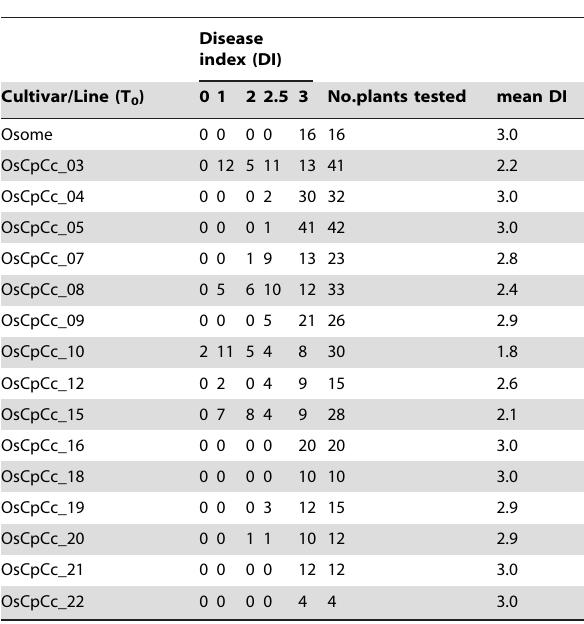
Table 1. Clubroot resistance of the transgenic Brassica rapa (T 1 ) carrying Crr1a promoter:: Crr1a cDNA